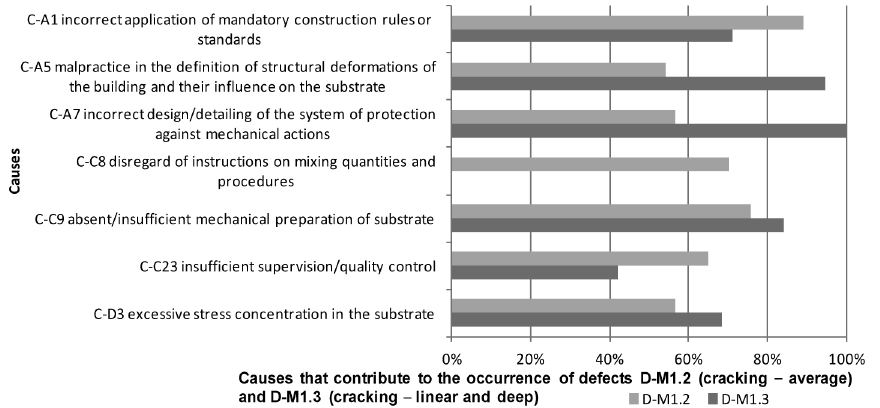
Fig. 11. Causes that contribute to the occurrence of defects D-M1.2 (cracking – average) and D-M1.3 (cracking – linear and